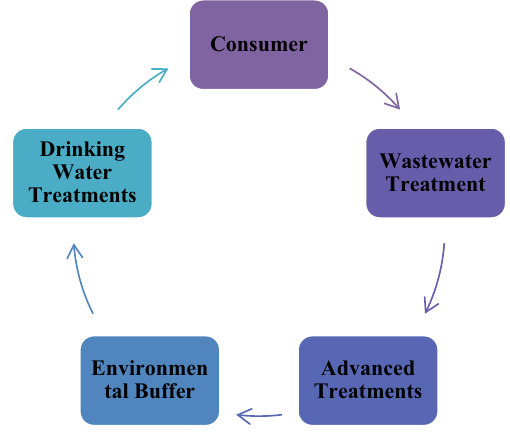
Fig. 2 Indirect potable reuse (IPR) cycle for recovering